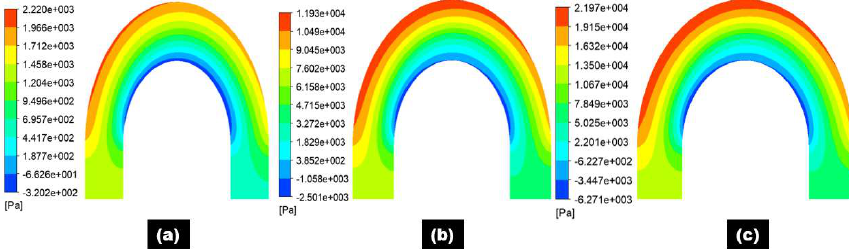
Figure 8. Pressure distribution contours of 180 ◦ U-bend for three different flow velocities: ( a ) 2 m/s; ( b ) 4 m/s; ( c ) 6 m/s.